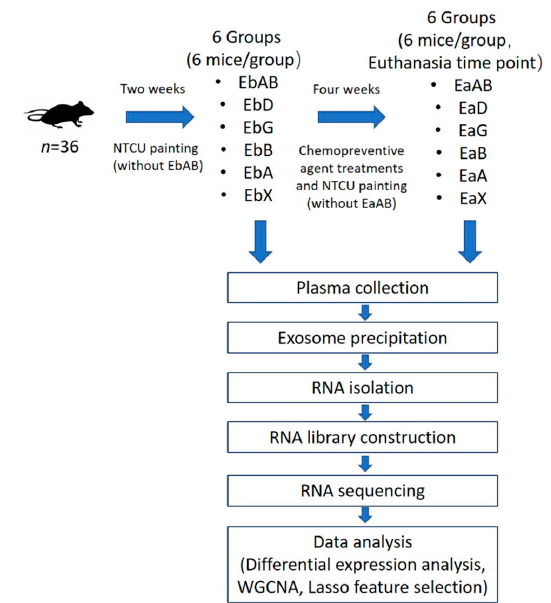
Figure 1. Flowchart of the experimental design. Among 36 mice tested in the study, except for 6